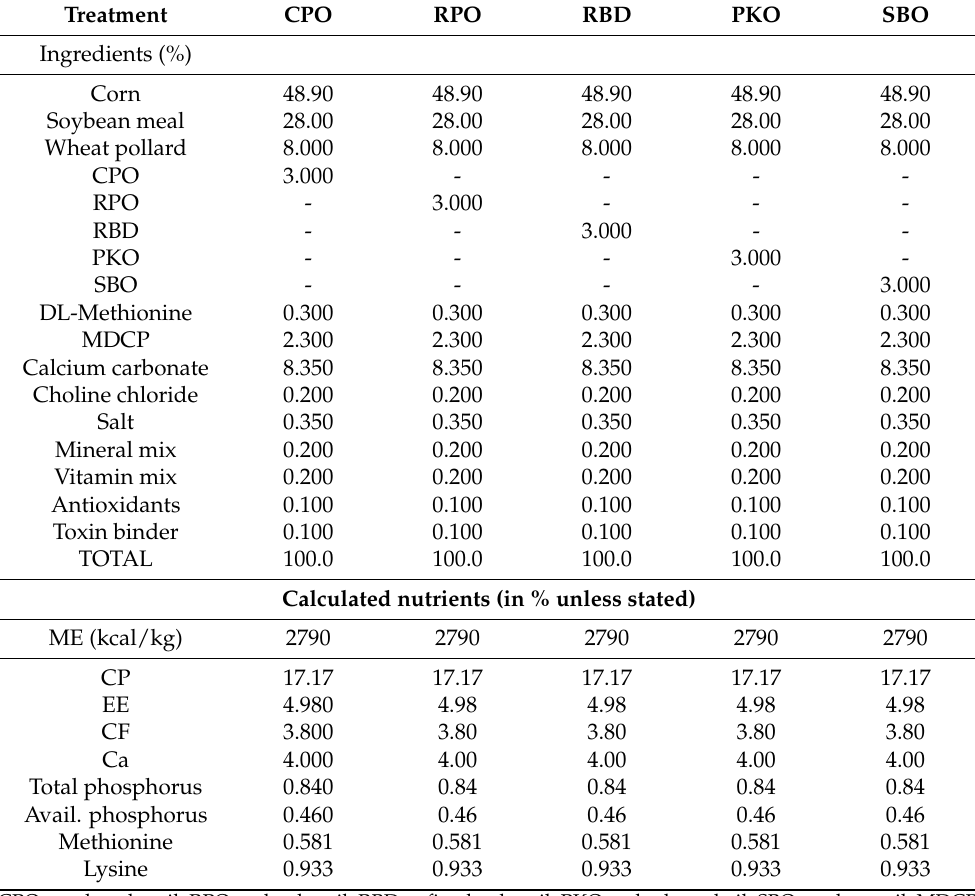
Table 1. Ingredients and nutrient profiles of feeds containing different oils.